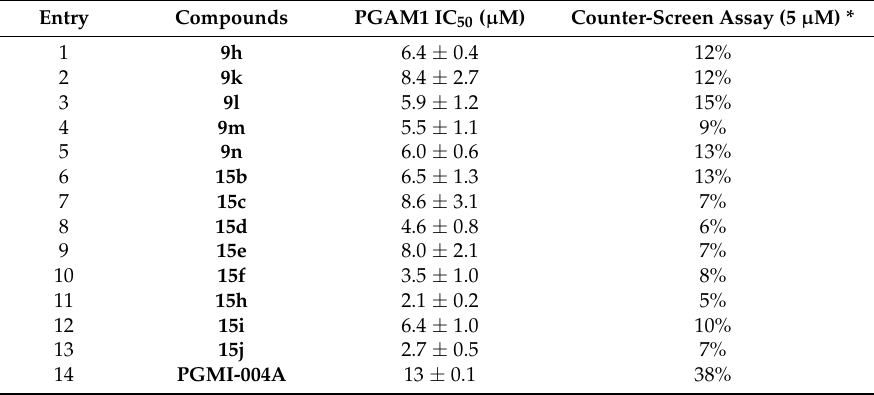
Table 3. The counter-screen assay of the representative compounds.